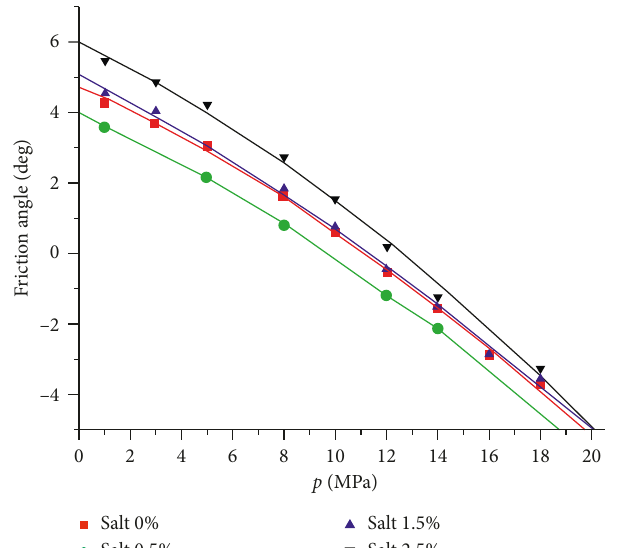
Figure 4: Relationship between hydrostatic pressure and friction angle of frozen saline silty clay with different salt contents.